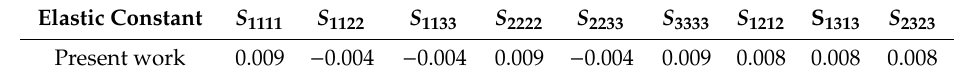
Table 2. Elastic constants S ijkl for single-crystalline Ni 3